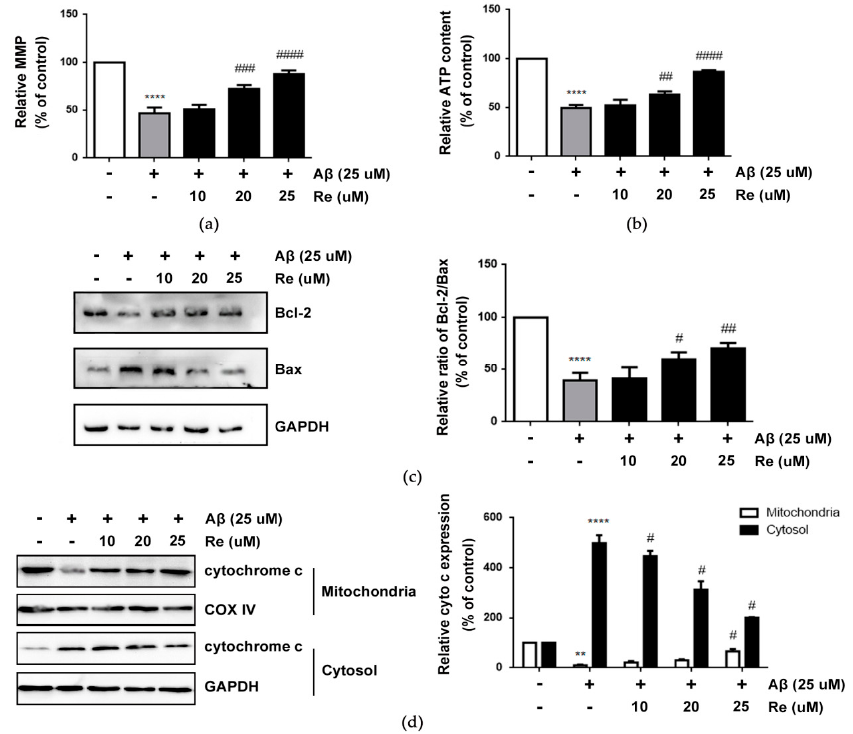
Figure 2. Ginsenoside Re alleviated mitochondrial dysfunction and prevents mitochondria mediated apoptotic pathway after A β 25–35 exposure in SH-SY5Y cells. ( a ) The loss of MMP in SH-SY5Y cells; ( b ) the relative ATP content in SH-SY5Y cells; ( c ) the protein expression levels of Bcl-2 and Bax in SH-SY5Y cells were detected by western blot analysis; ( d ) western blot analysis to detect cytochrome c levels in mitochondrial fraction and cytosolic fraction of SH-SY5Y cells. ** p < 0.01, **** p < 0.0001 versus control; # p < 0.05, ## p < 0.01, ### p < 0.001, #### p < 0.0001 versus A β treatment